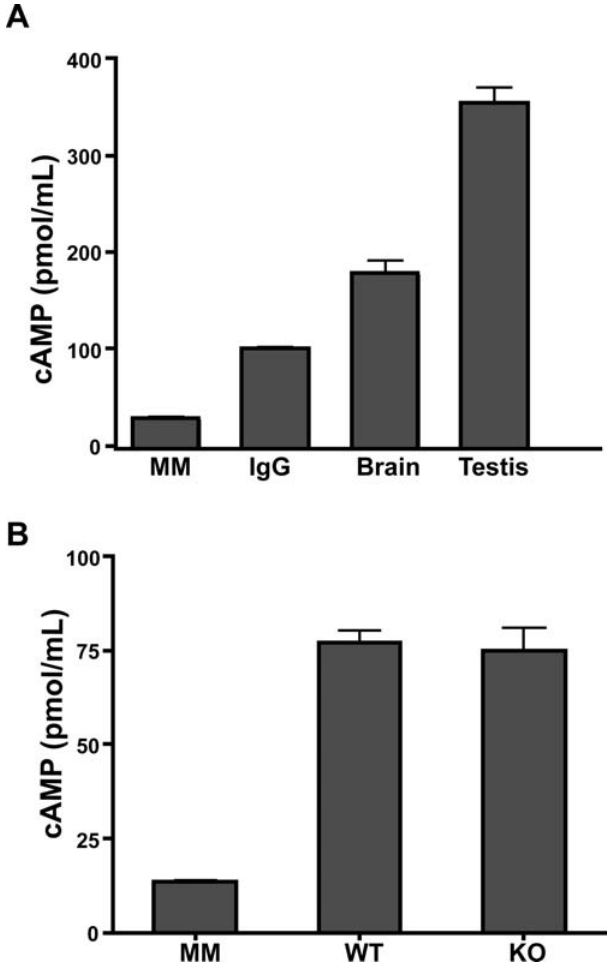
Figure 3. Somatic sAC activity in brain is lower than activity in testis, but it is not diminished in brains from Sacy tm1Lex / Sacy tm1Lex mice. (A) Adenylyl cyclase activity (in pmol cAMP formed per ml) in mouse IgG or R37 IP from detergent extracts from a single